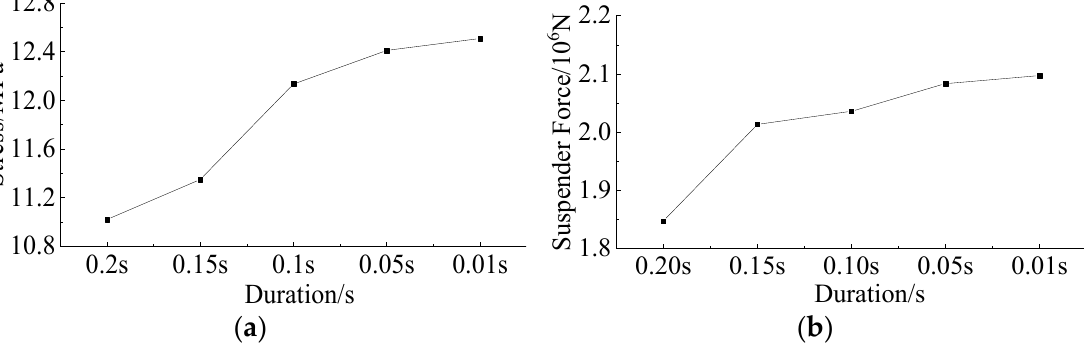
Figure 21. The maximum dynamic response corresponding to each working condition: ( a ) the longitudinal beam; ( b ) the adjacent suspenders.